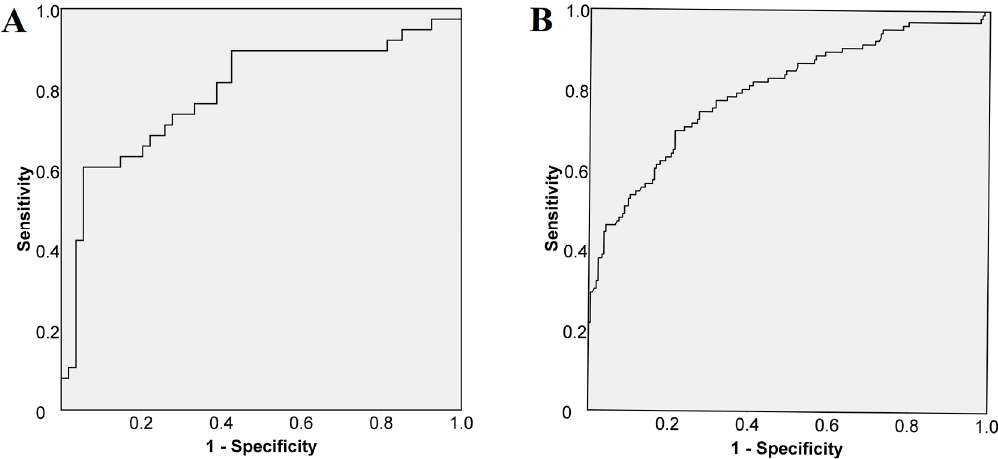
Figure 2. Receiver operating curve ( A ) to predict histologically confirmed cirrhosis ( N = 92): sensitivity 74%; specificity 72%; area under the curve (AUC) 0.791, and ( B ) to predict liver stiffness cut ‐ off for cirrhosis ( N = 322): sensitivity 75%; specificity 73%; AUC 0.799. The biopsy results indicated significantly higher VAP ‐ 1 concentrations in patients with cirrhosis